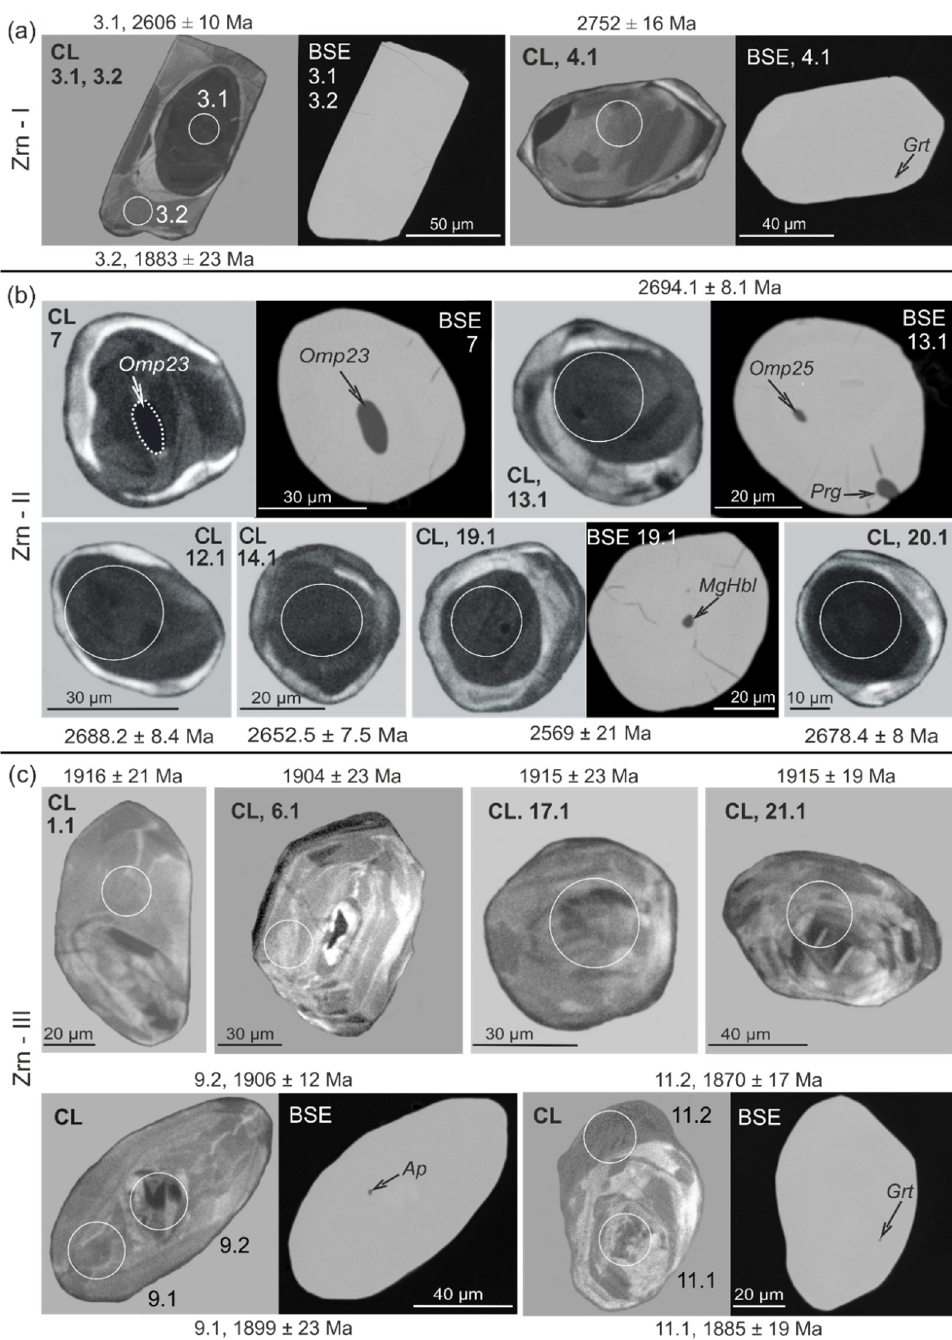
Figure 4. Cathodoluminescence (CL) and back-scattered electron (BSE) images of ( а , b ) Archean zircons Zrn-I ( a ) and Zrn-II ( b ), and Zrn-III ( c ) Paleoproterozoic zircons from eclogite ST-2D; ovals and circles indicate the SHRIMP spot locations (not to scale), and are labelled with the spot number and the approximate spot 207 Pb/ 206 Pb age ( Ap = apatite).